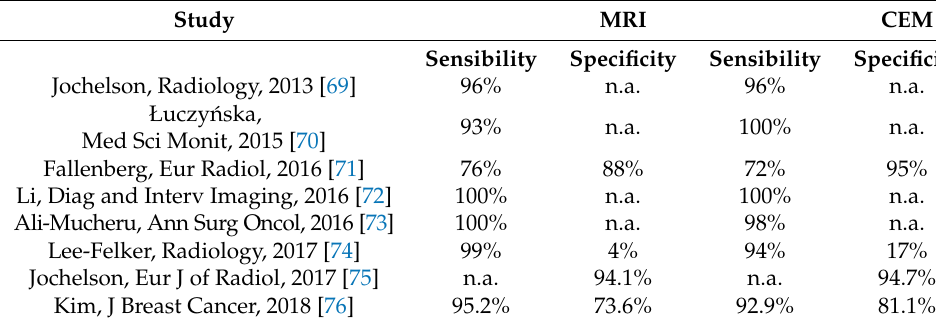
Table 2. Diagnostic performance of CEM compared to